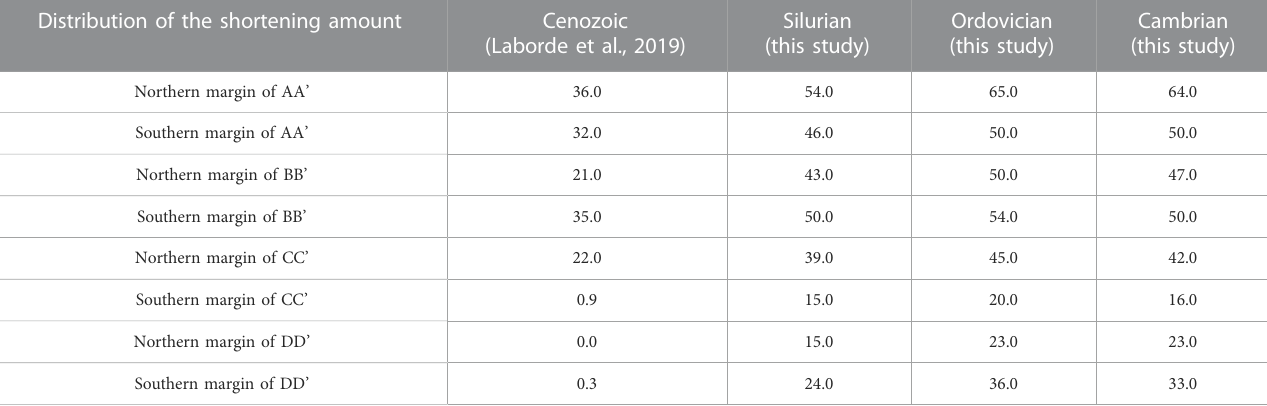
TABLE 2 Shortening amount of Tarim Basin from Cenozoic, Silurian, Ordovician, Cambrian to the present (km). Distribution of the shortening